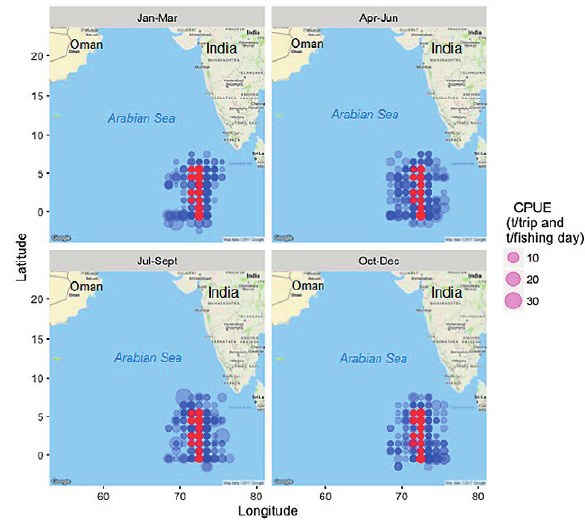
Fig. 9. – Quarterly maps of the total CPUE off Brazil (units: in blue t/fishing day; in red t/effective fishing day).